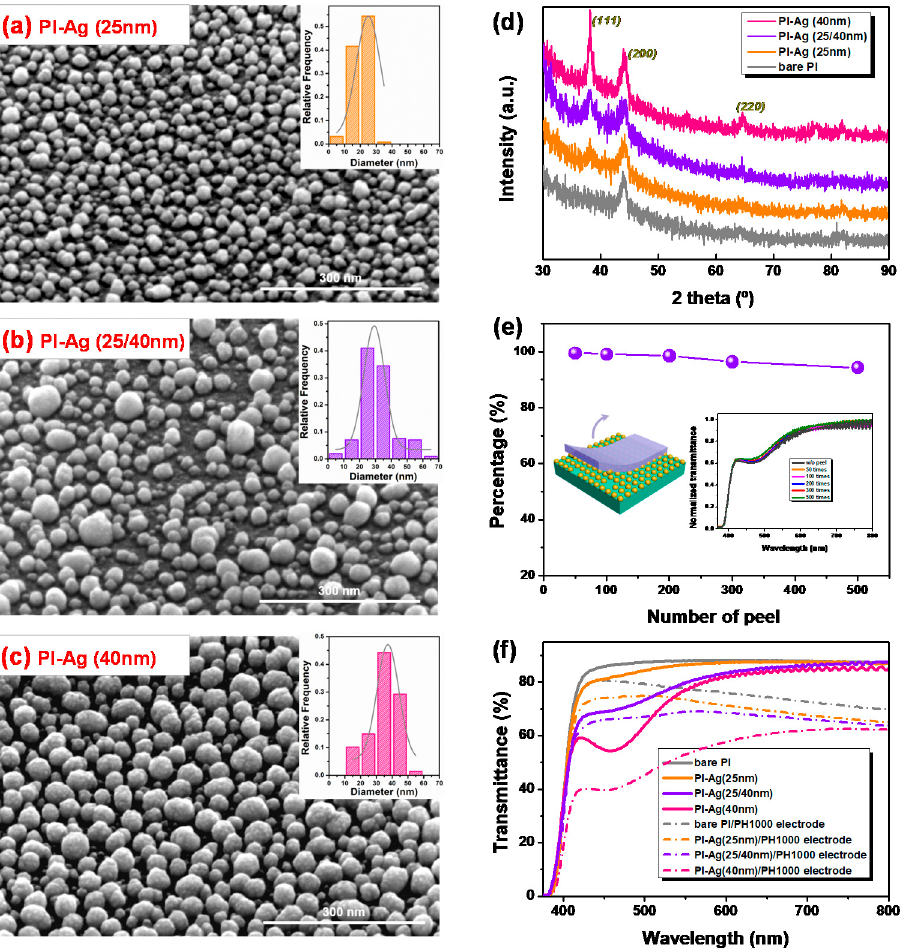
Figure 2. ( a – c ) The scanning electron microscopy (SEM) image of PI with the various sizes of Ag nanoparticles (inset: the size distribution histogram showing the diameter of ~25, ~25/40 and ~40 nm, respectively). ( d ) X-ray diffraction (XRD) patterns for PI film with different sizes of Ag nanoparticles. ( e ) The adhesive strength of the Ag covered on the surface-modified PI (inset: the transmittance spectrum of the Ag-modified PI films with various numbers of peels). ( f ) Optical transmittance of the bare PI and PI adhered with different sizes of Ag nanoparticles (solid line), and their corresponding transmittance after coating the PH1000 electrodes (dash line).